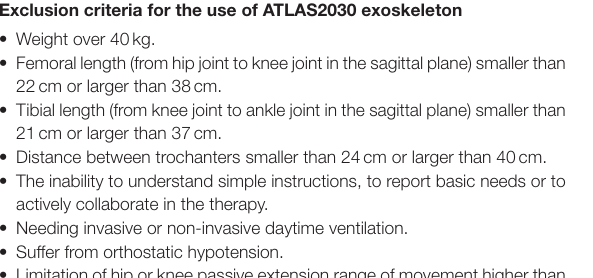
TABLE 1 | Exclusion criteria for use of the device. Exclusion criteria for the use of ATLAS2030